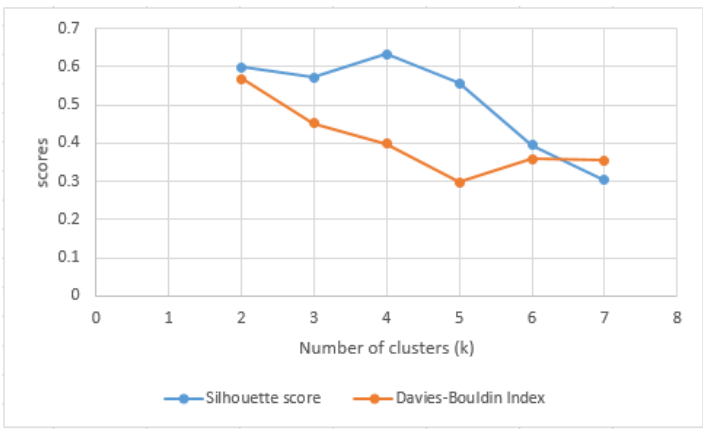
Figure 10. Silhouette score (blue) and Davies-Bouldin index (orange) relative to the number of clus- ters.